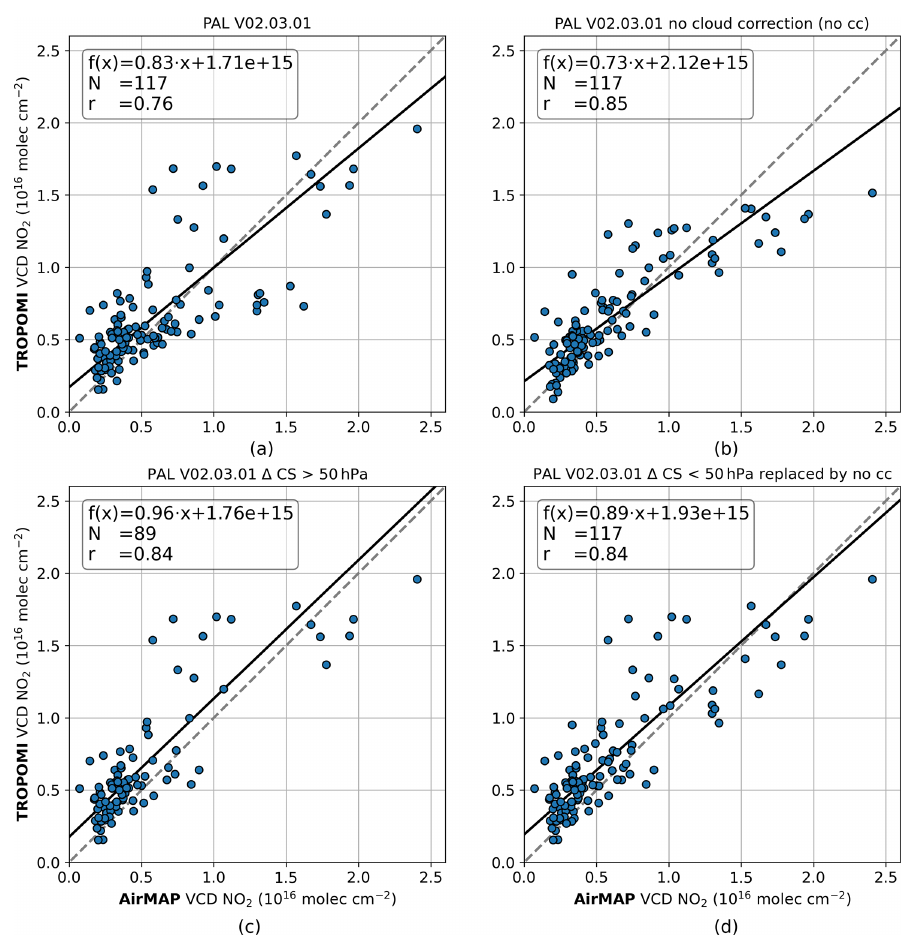
Figure 10. Scatter plots of TROPOMI NO 2 VCDs vs. co-located AirMAP NO 2 VCDs for different versions of TROPOMI data: (a) PAL V02.03.01, (b) PAL V02.03.01 without cloud correction, (c) PAL V02.03.01 only pixels with a surface and cloud pressure difference of (cid:49) CS > 50hPa, and (d) PAL V02.03.01 pixels where (cid:49) CS < 50hPa are replaced by NO 2 VCDs without cloud